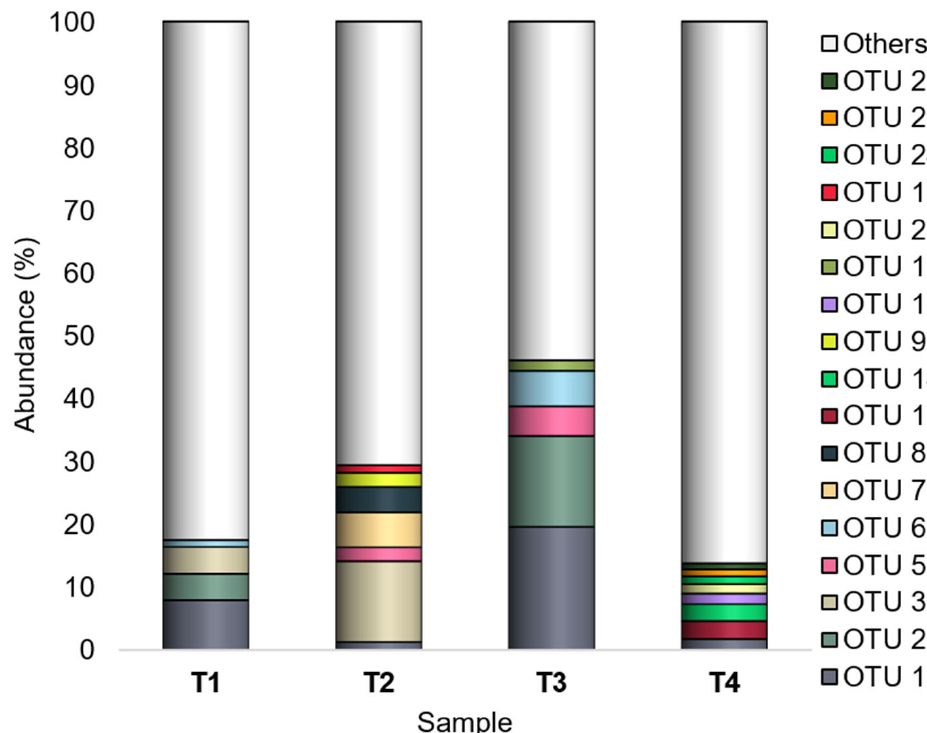
Figure 4. Bacterial composition at the OTU level. Distribution of the major OTUs (Ra ≥ 1% in at least one sample); OTUs with Ra < 1% were gathered in “Others”. T1: WT/OF, T2: WT/CF, T3: SB/OF, T4: SB/CF.